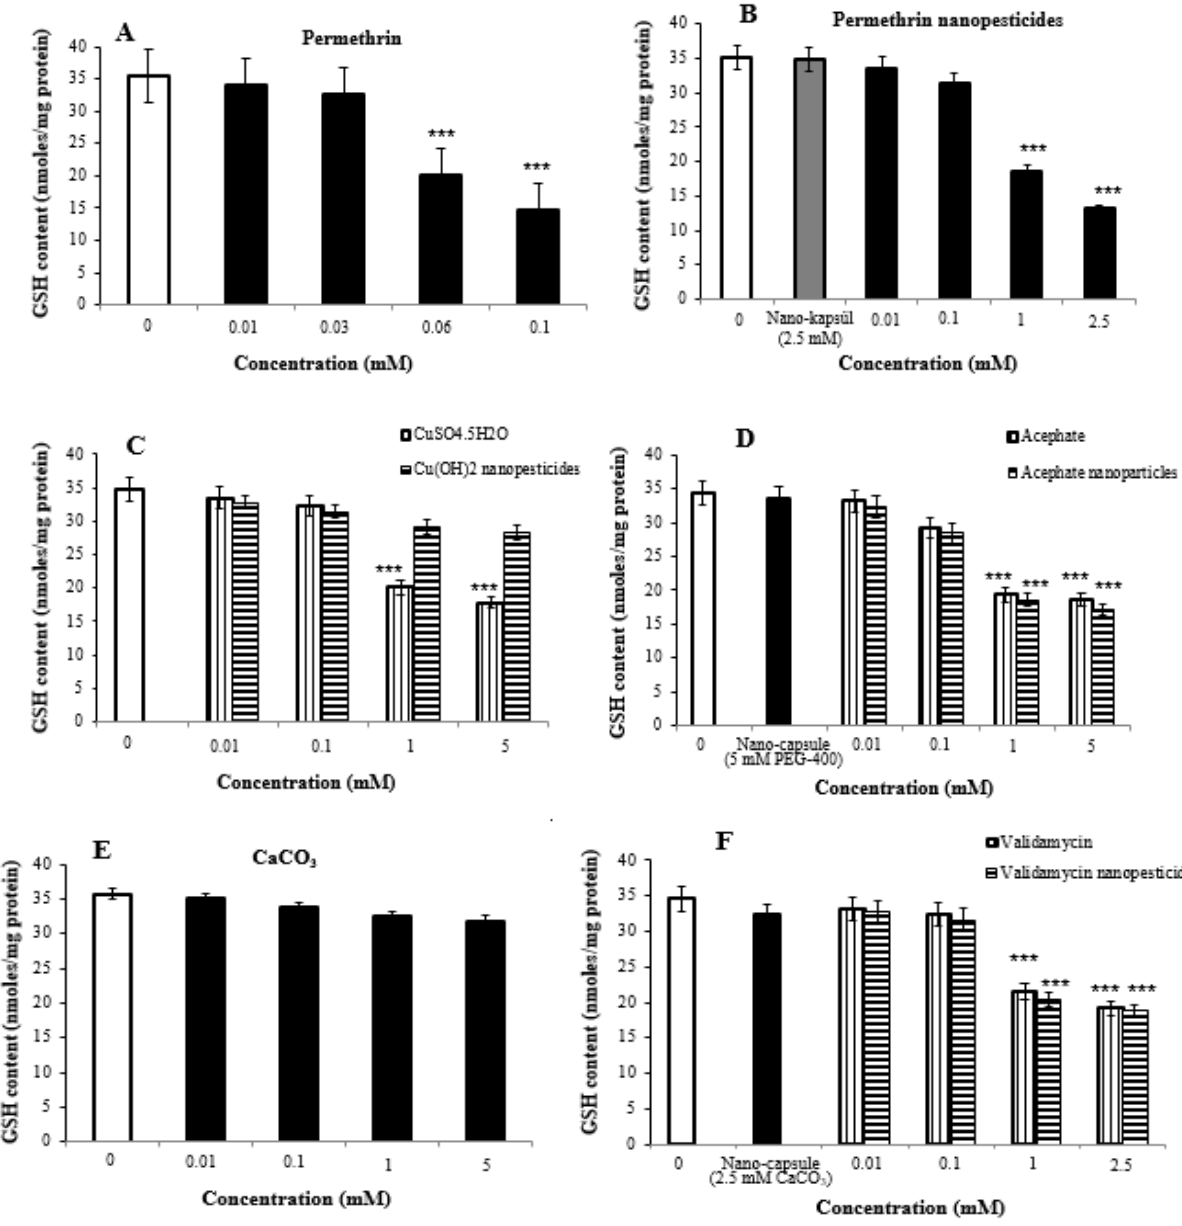
Figure 6. GSH contents in untreated controls (distilled water) and in permethrin ( A ), permethrin nanopesticides ( B ), CuSO 4 · 5H 2 O and Cu(OH) 2 nanopesticides ( C ), acephate and acephate nanopesticides ( D ), CaCO 3 ( E ), and validamycin and validamycin nanopesticides ( F ) given to third-instar larvae of Drosophila . Each point represents a mean of 5 replicates ± SE; *** p ≤ 0.001 when compared to the negative control using Student’s t -test.